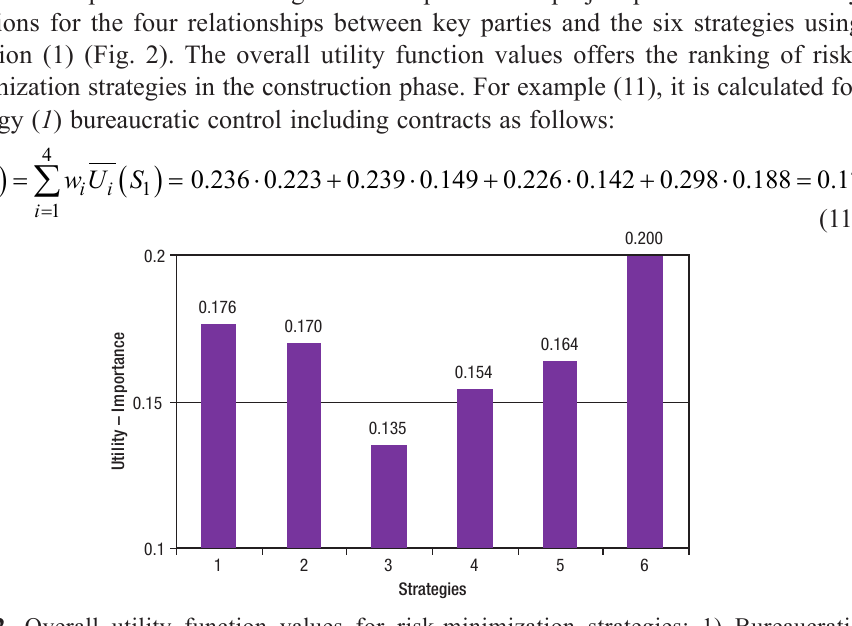
Fig. 2. Overall utility function values for risk-minimization strategies: 1) Bureaucratic control (contracts); 2) Information Systems; 3) Incentives (bonuses); 4) Corporate